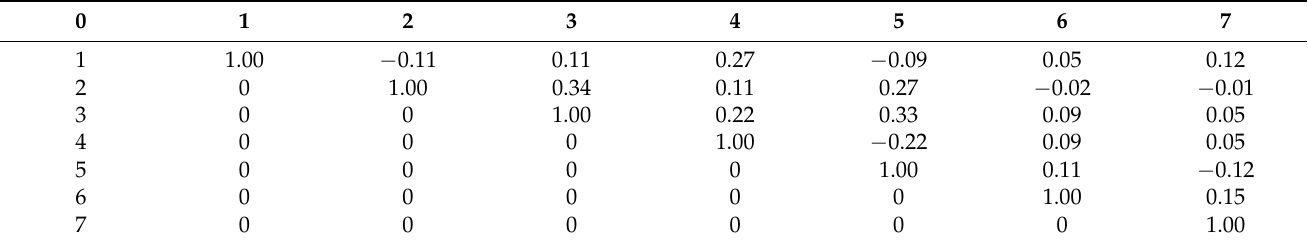
( 3 ) ( i ) ; ν ,i = 1,7 (preceding crop—maize). 1 ν